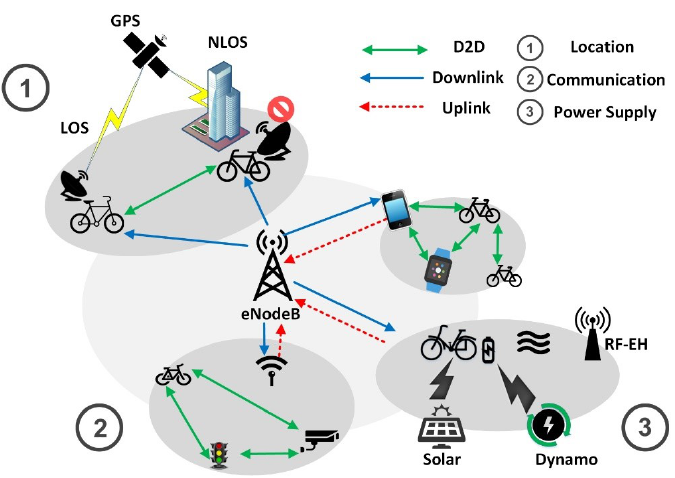
Figure 11. Green IoSB vision in